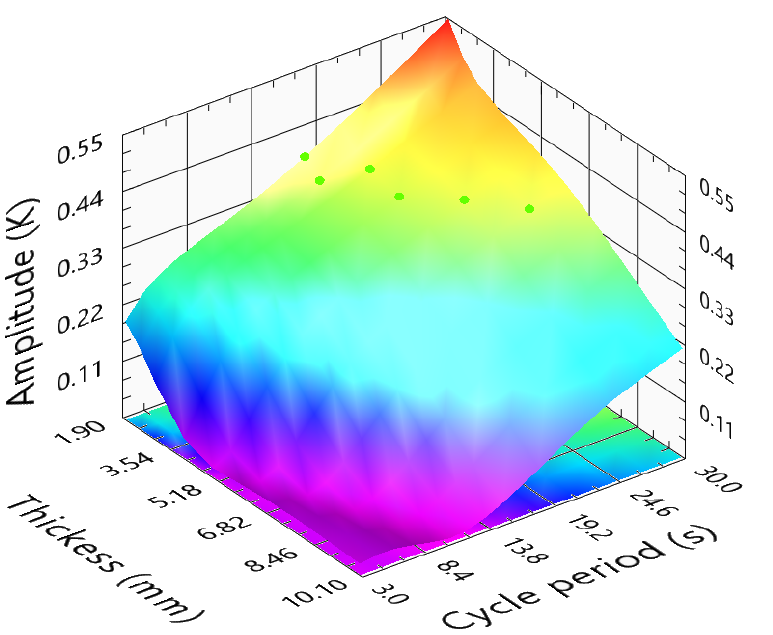
Figure 16. Amplitude difference function of the sample thickness and cycle period, for CFRP samples.